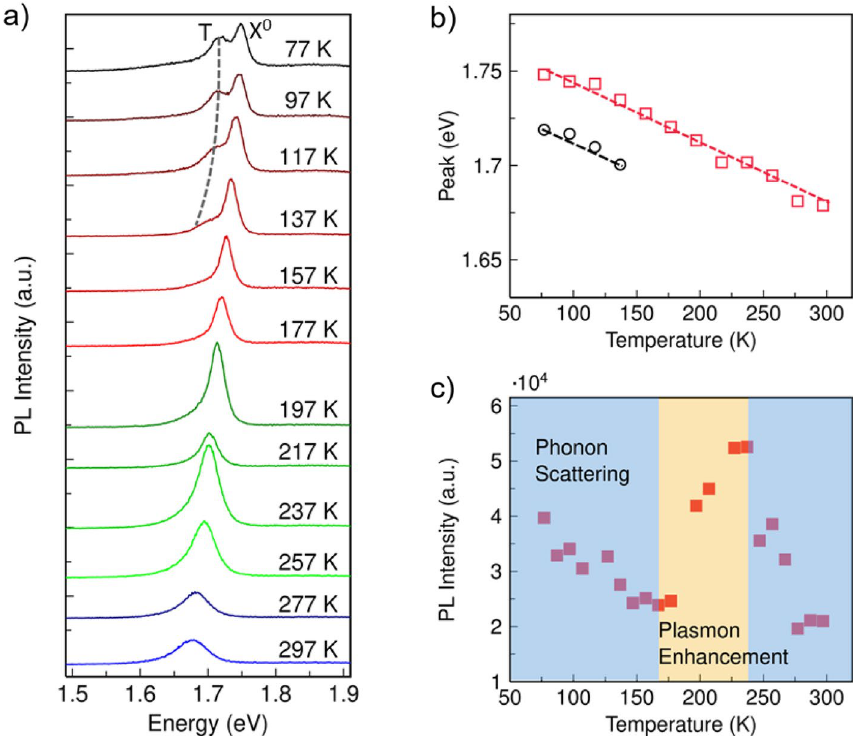
Figure 4. Temperature-dependent PL characteristics. ( a ) Temperature-dependent PL emission from exciton (X 0 ) and trion (T) of WSe 2 /Nanocavity. ( b ) PL peak position as a function of temperature. Black dots denote the trion peak and red dots denote the exciton peak, which are fitted by dashed lines. The PL was excited by using laser with energy of 1.96 eV and power of 20 μW. ( c ) Integrated PL intensity of WSe 2 /Nanocavity with peak integrated from 1.62 to 1.78 eV, as a function of temperature. The decreasing and increasing regimes are denoted in blue and orange, respectively. The intensity evolution revealed a combined effect of phonon scattering and plasmon